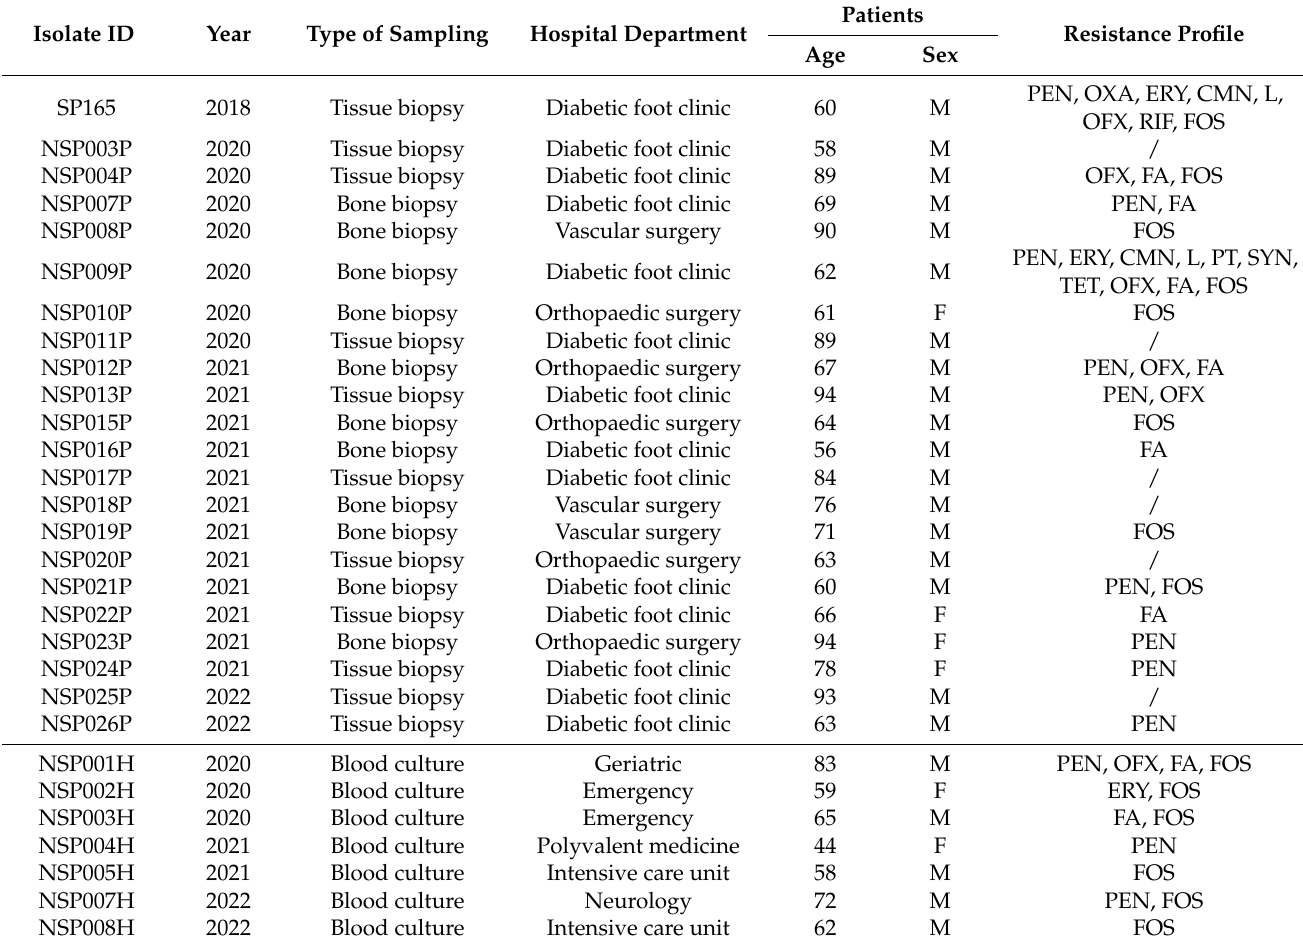
Table 1. Characteristics and resistance profiles of the studied S. pettenkoferi strains ( n =